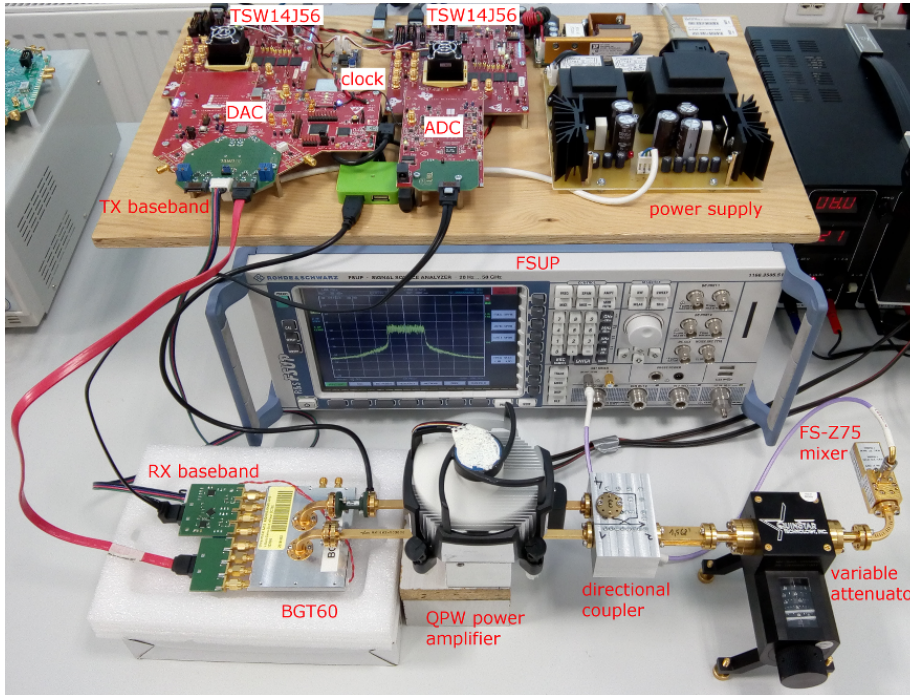
Figure 2. Photo of the described mm-wave 60 GHz